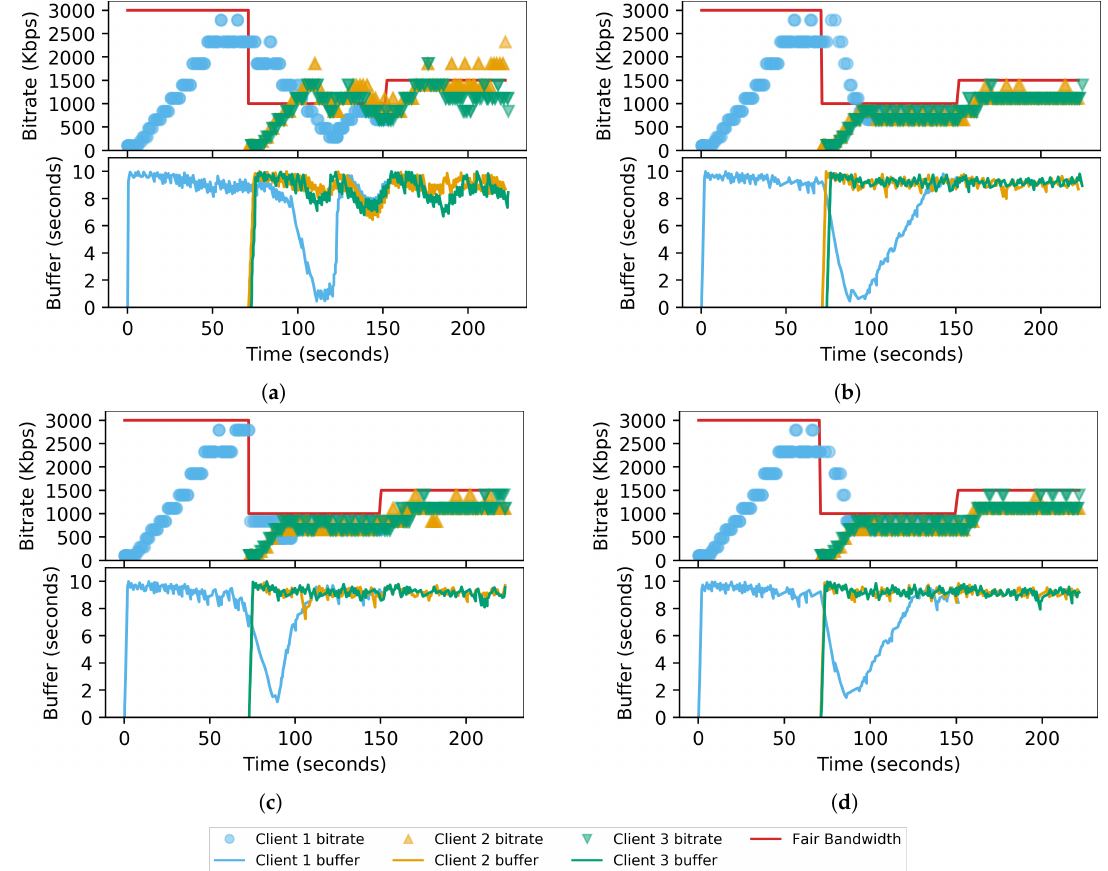
Figure 7. Time-varying performances of all methods in subscenario 2-B. ( a ) No-Proxy; ( b ) Reactive; ( c ) Proactive; ( d )